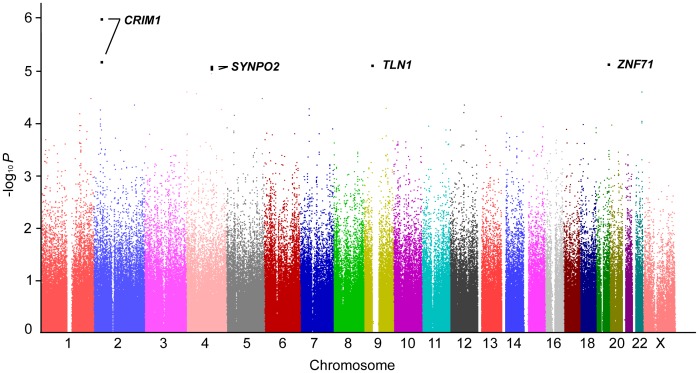
Graphical summary (Manhattan plot) presenting P-values for the association with total serum IgE in asthma patients.The y-axis represents -log10
P (linear regression analysis) from 442,117 SNPs in 877 patients with asthma, correcting for age, gender, and smoking status as covariates; the x-axis indicates its physical position on successive chromosomes.